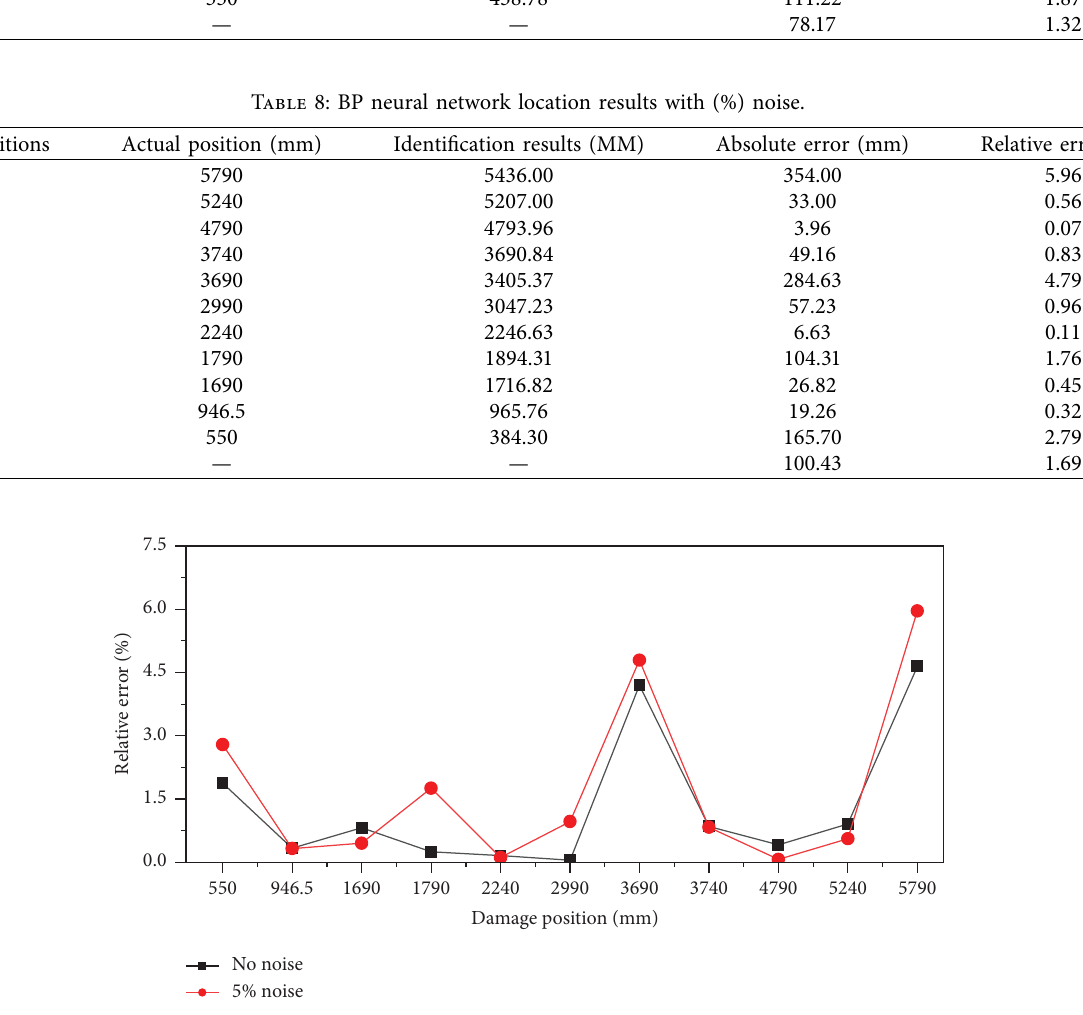
Figure 16: BP neural network localization results for the fnite element damage model. Table 9: Vibration test BP neural network location results.